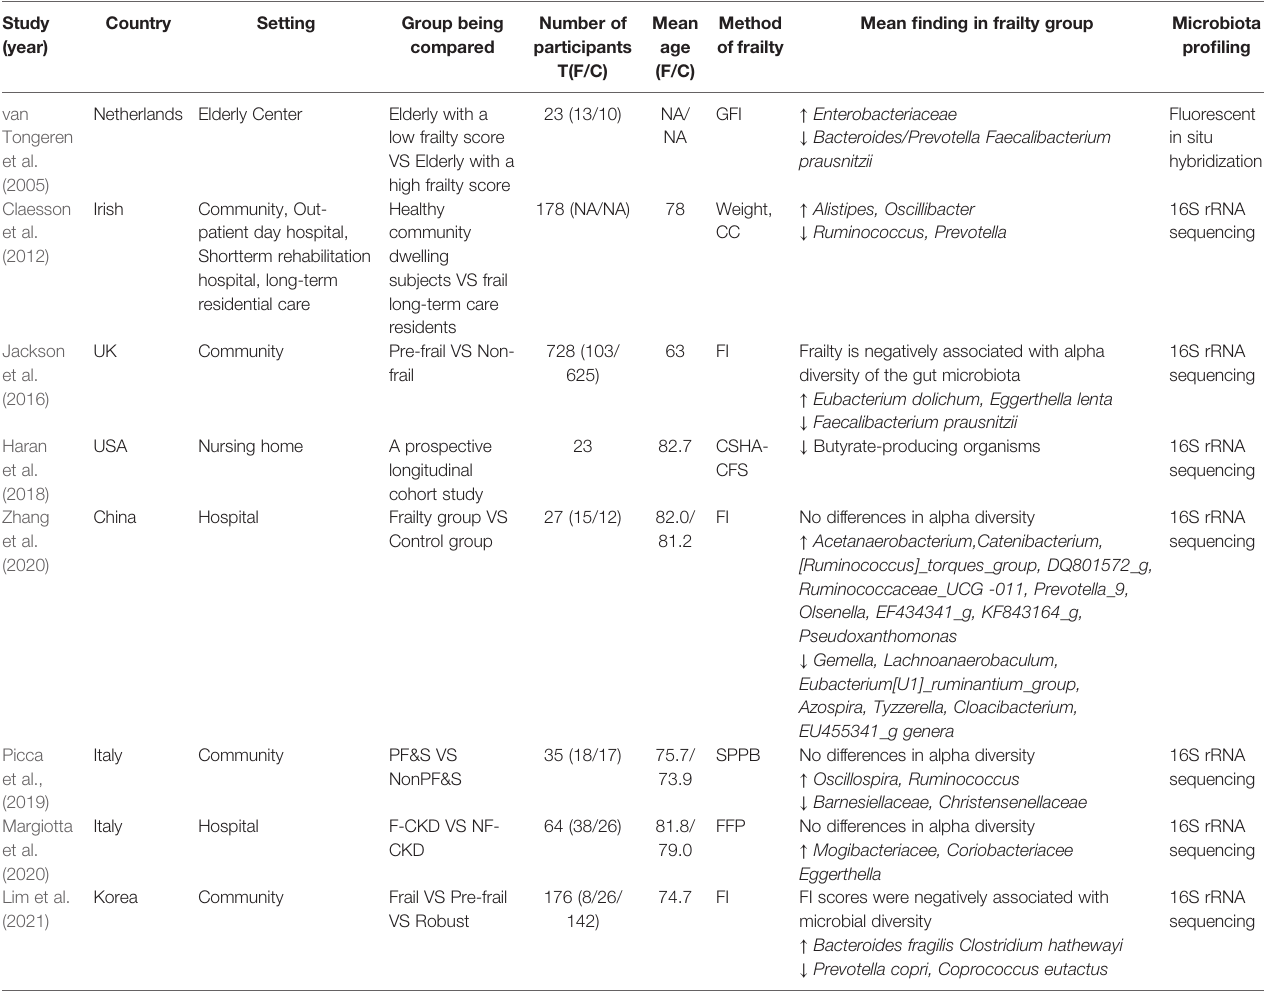
TABLE 2 | Studies investigating the association between fecal microbiota composition and frailty in older adults.